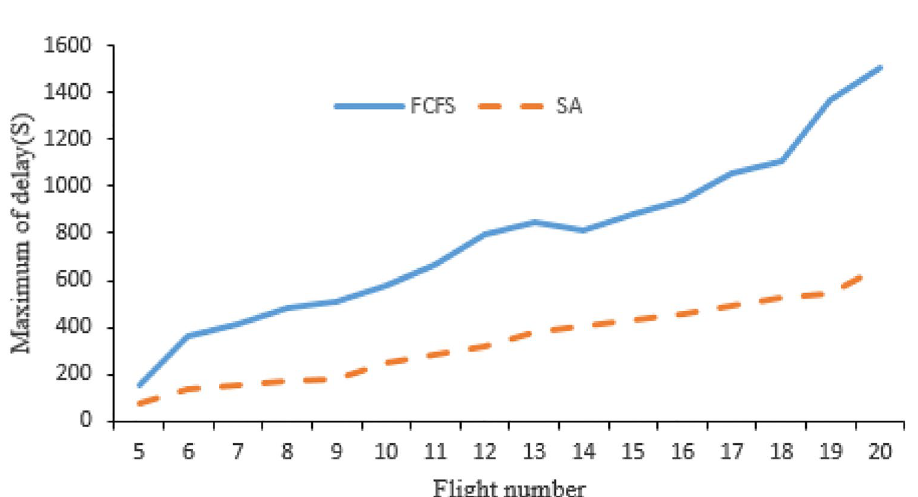
Fig. 8 The maximum delay of FCFS and